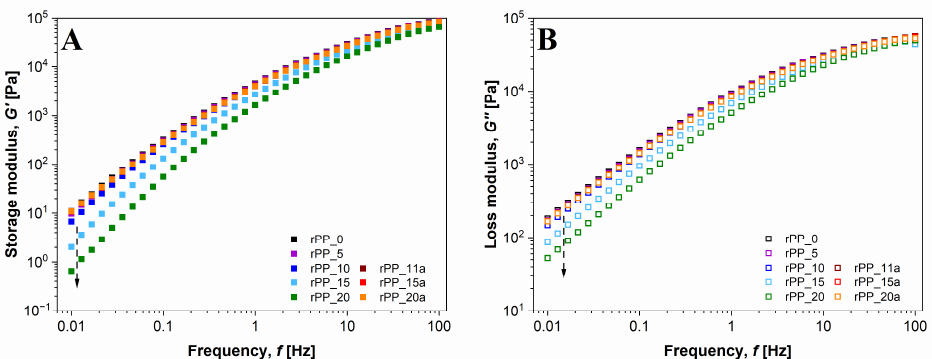
Figure 5. Frequency dependency of ( A ) storage modulus G’ and ( B ) loss modulus G” of virgin PP, recycled PP without and with additive depending on the processing cycle (at 190 °C).